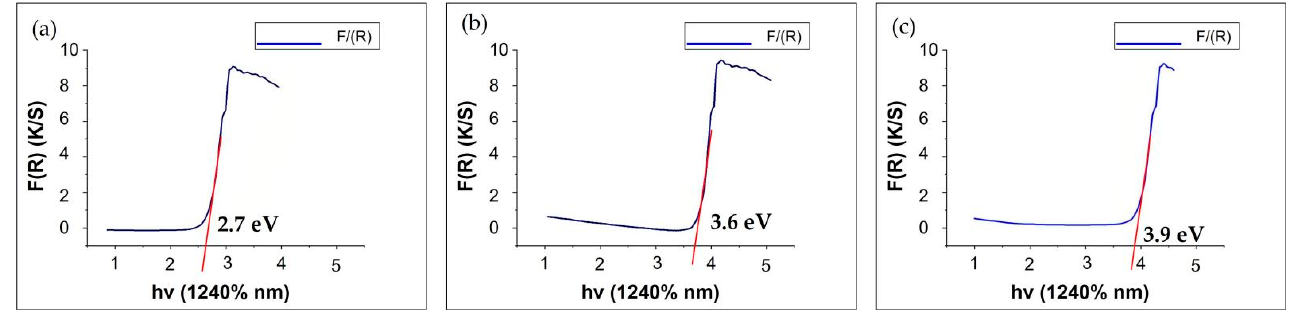
Figure 7. DRS scan of titanium nanoparticles formed by: ( a ) Bacillus subtilis , ( b ) Cassia fistula and ( c ) hydrothermal heating showing band-gap absorbance energy.